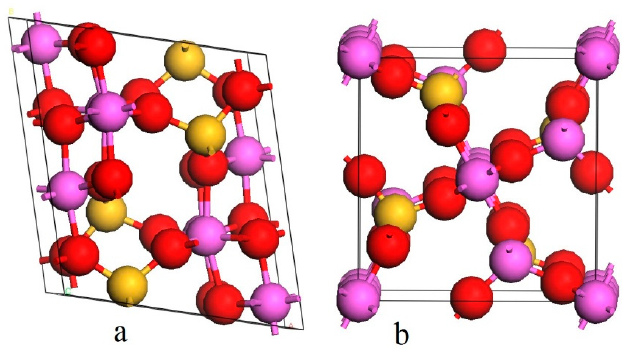
Figure 1. The unit cell model of kyanite ( a ) and sillimanite ( b ). Atom color: pink = Al, red = O, yellow = Si.